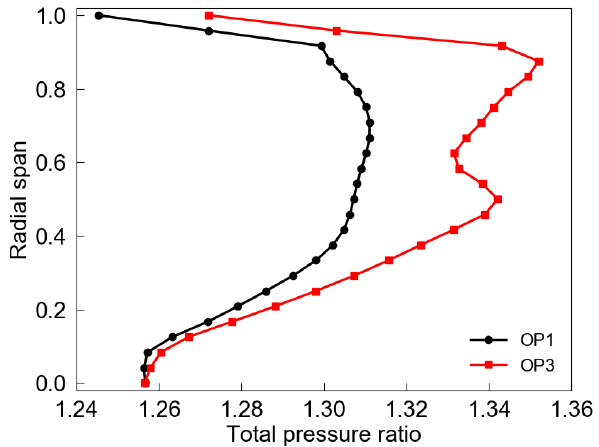
Figure 6. Comparison of radial profiles of bypass flow total pressure